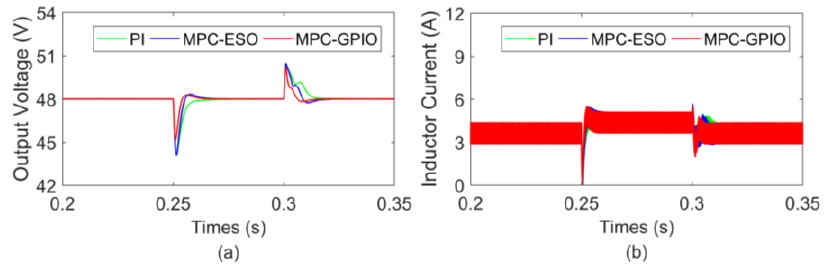
Figure 5. Dynamic response of TIBC under step input voltage change at 0.25 s and 0.3 s: ( a ) output voltage; ( b ) inductor current.